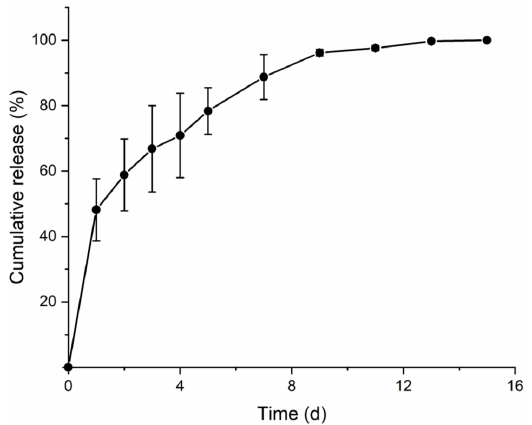
Figure 6. Cumulative release profile of separable polycaprolactone (PCL) dissolving microneedle (SPCL-DMN) array, with PCL encapsulating 20% ( w / w ) capsaicin, in porcine skin over 15 days ( n = 2) determined using a Franz diffusion cell. Notably, 99.7% ± 0.31% of capsaicin was released within 13 days.